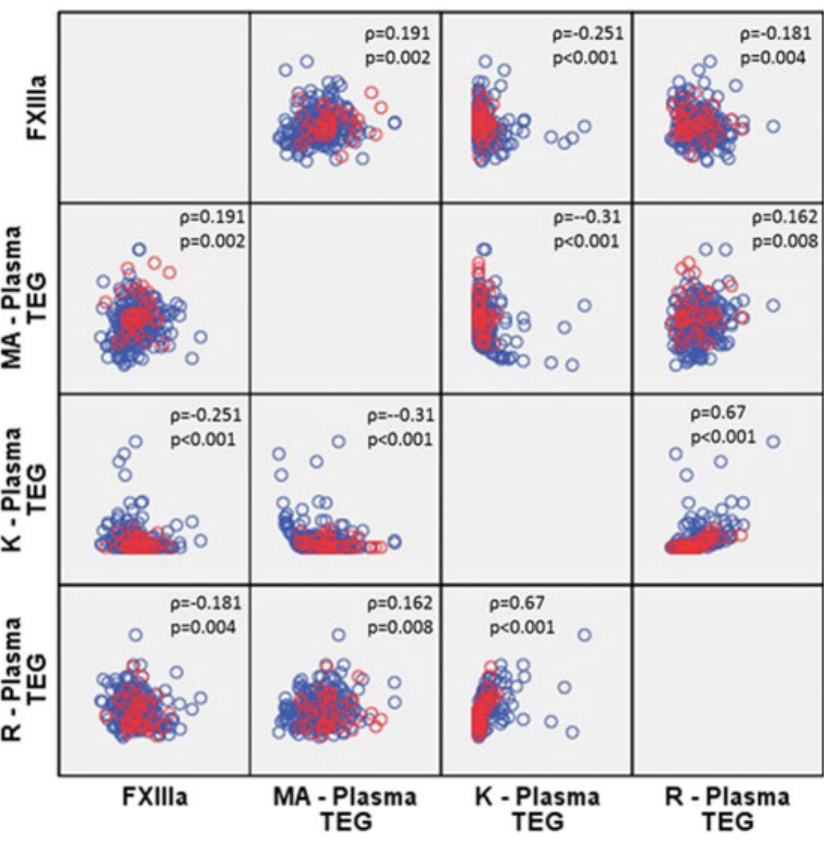
Fig. 1 Scatterplot of thrombelastography (TEG) and FXIIIa measures in subjects without events (blue) and subjects with cardiovascular death or MI (red). FXIIIa, factor XIIIa; TEG-K, clot formation time; TEG-MA, maximal fi brin clot strength; TEG-R, time to fi brin formation.